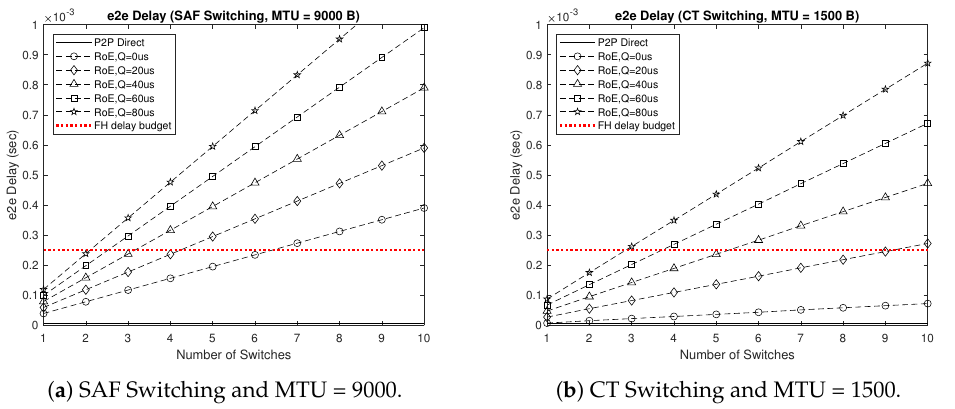
Figure 7. e2e delay results of the proposed 5GB neutral host design architecture for the stadium deployment